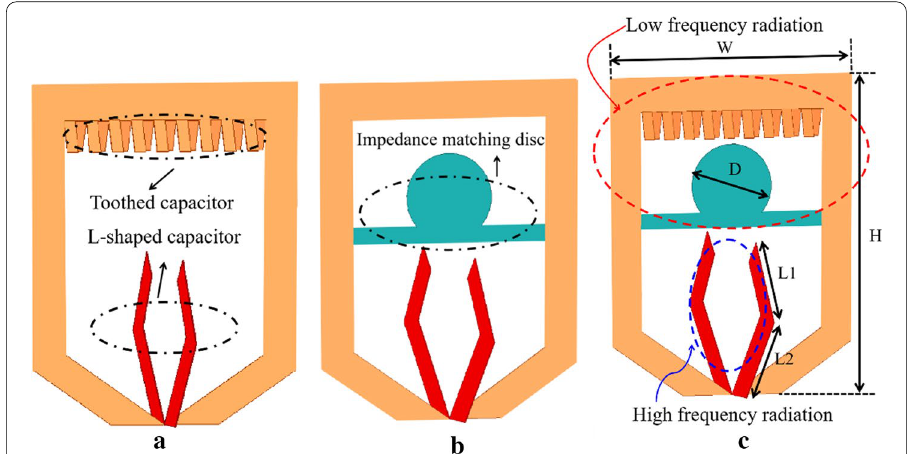
Fig. 3 Three kinds of rooftop antennas with different performances. a Antenna with toothed capacitor and L-shaped capacitor. b Antenna with impedance matching disk. c The proposed wideband antenna structure